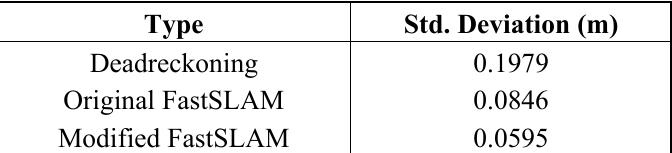
Table 4. Standard Deviation of Estimation Errors.